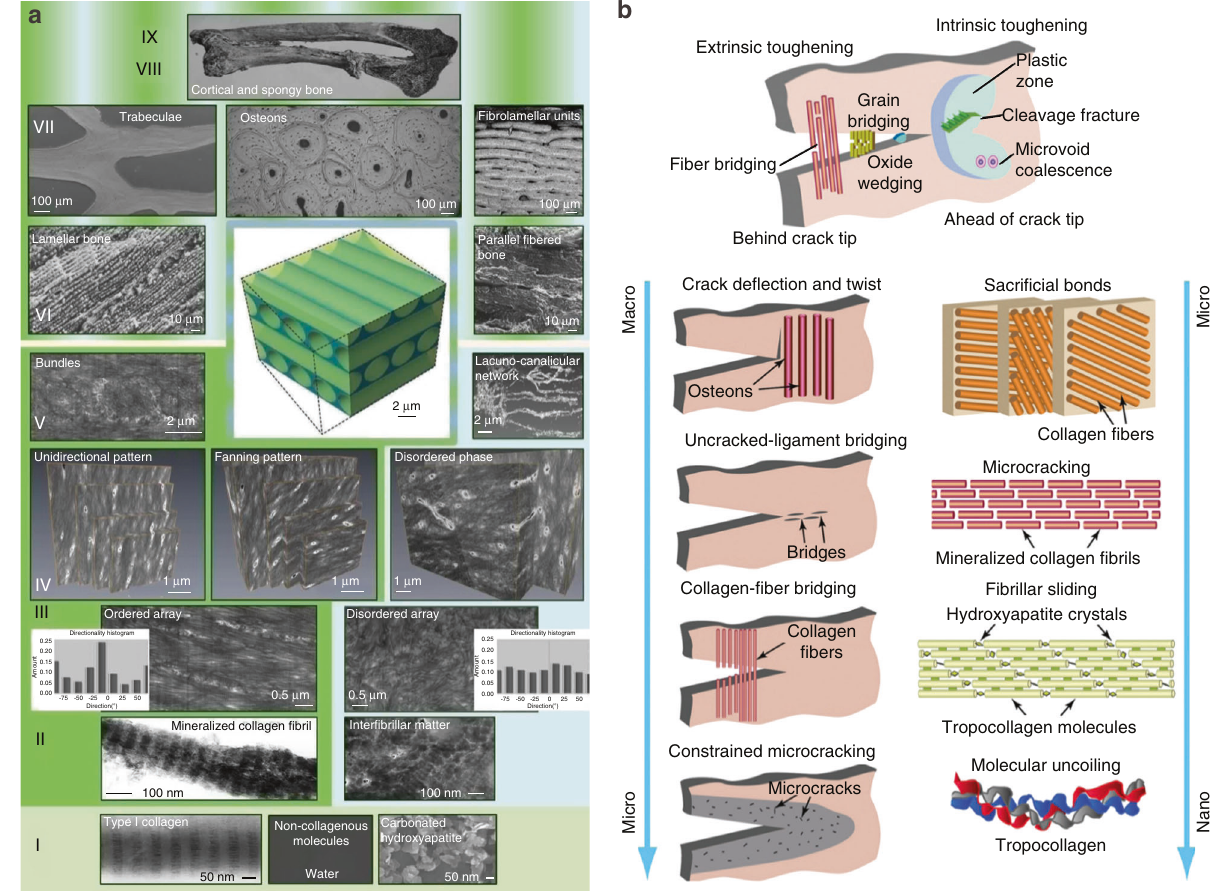
Fig. 5 Multistage structure of bone matrix and its toughening mechanism. a Nine-level structure of bone 67 . b Schematic diagram of the mechanism of bone toughness 6 . Figures adapted with permission from refs.